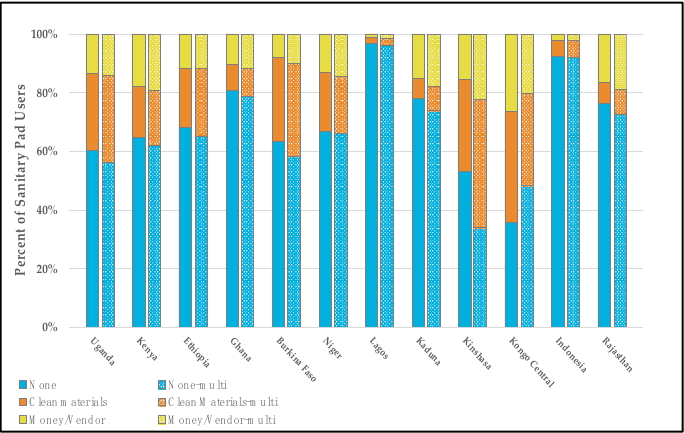
Figure 1. Reported menstrual material needs of menstrual pad users whose pad use was categorized using a single-response variable denoting exclusive pad use (left) and a multi-response variable denoting any pad use (right, patterned). Response options included no material needs (blue, bottom), clean materials (orange, middle), and money/vendor (yellow, top).